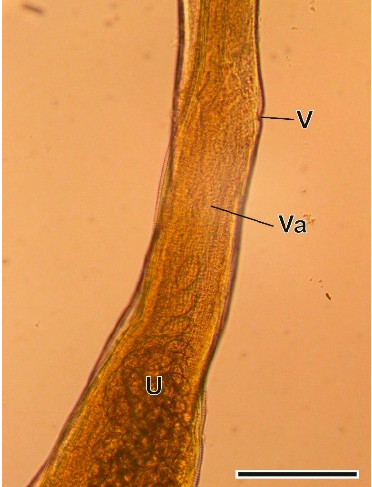
Figure 5. Vulvar region of a Trichuris arvicolae female. U, uterus; V, vulva; Va, vagina. Scale bar = 200 µm.